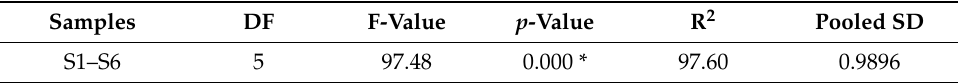
Table 3. One-way analysis of variance (ANOVA) results.